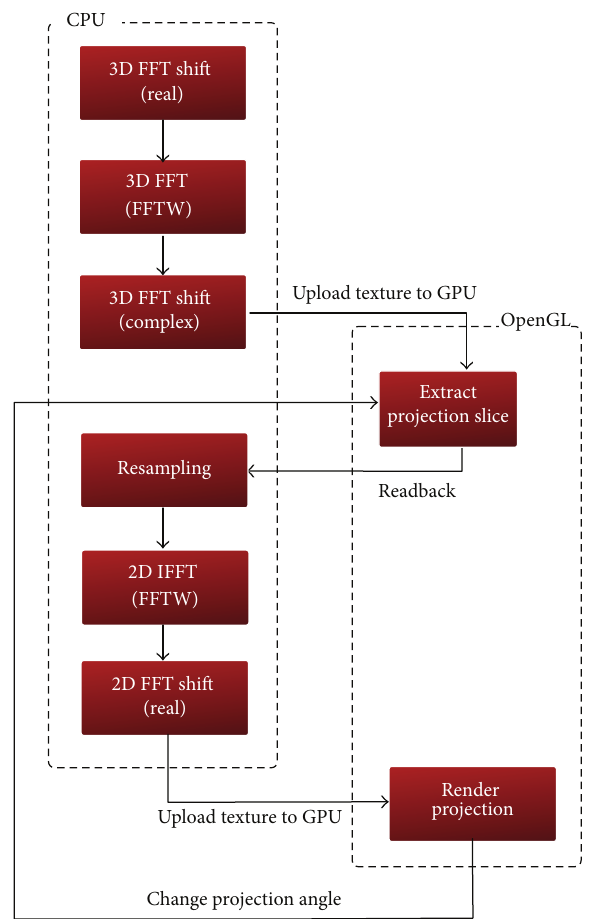
Figure 2: Heterogeneous implementation of the FVR pipeline. The computational context is executed on the CPU and the rendering contexts are executed in OpenGL contexts on the